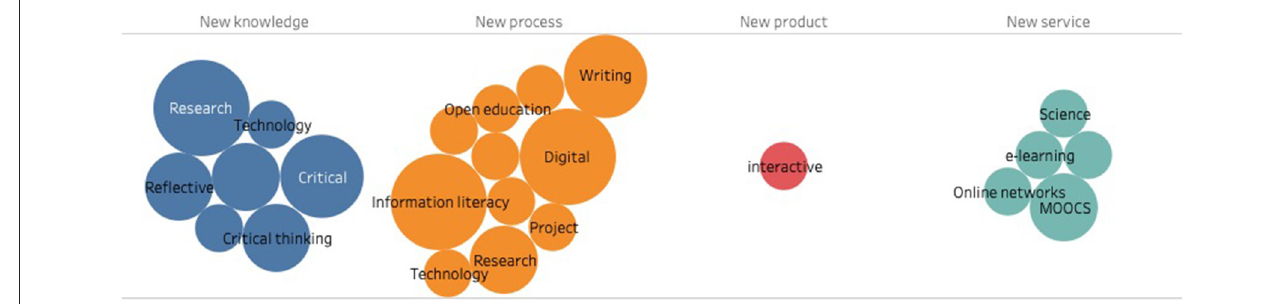
FIGURE 4 | Findings in research skills for academic literacy development.